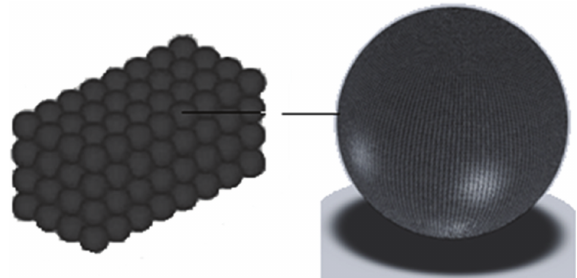
Figure 2: This one granule was then clone to 36 granule 65 and 114